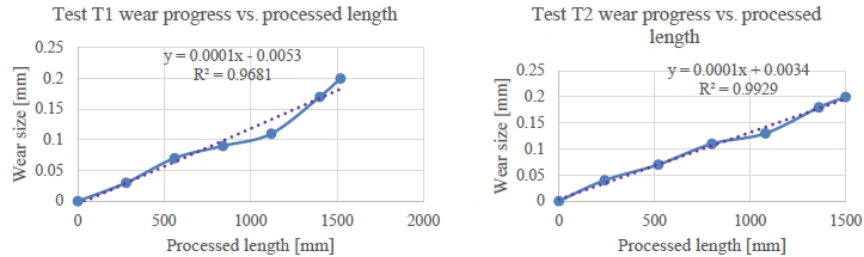
Figure 23. Wear progress versus the processed length, in case of test T1 and T2.